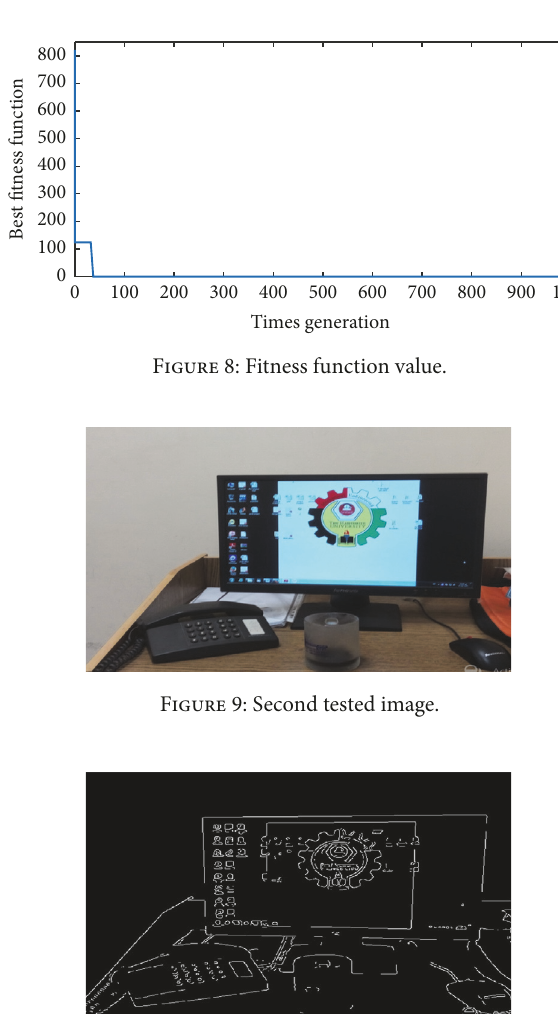
Figure 10: The tested image